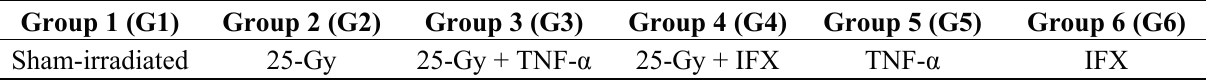
Table 1. Different groups of mice based on their treatment used in the